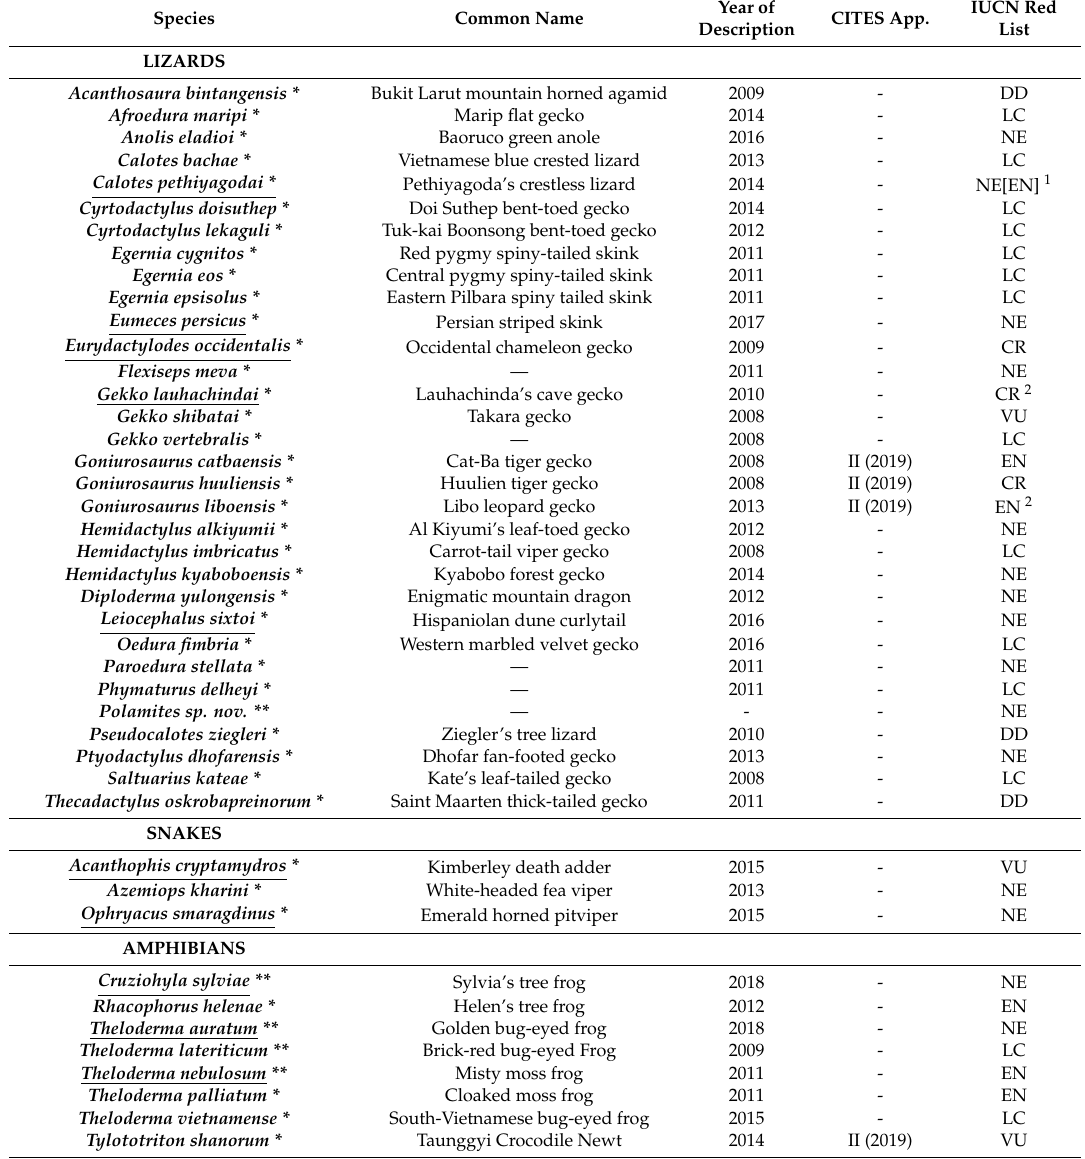
Table A1. Species only described since 2008 and recorded in the European pet trade. Ordered by taxa and alphabet. Species of dataset 1 are marked with *, species of dataset 2 with **. Underlined species were selected as case studies. CR = Critically Endangered, DD = Data Deficient, EN = Endangered, LC = Least Concern, NE = Not Evaluated, NT = Near Threatened, VU =